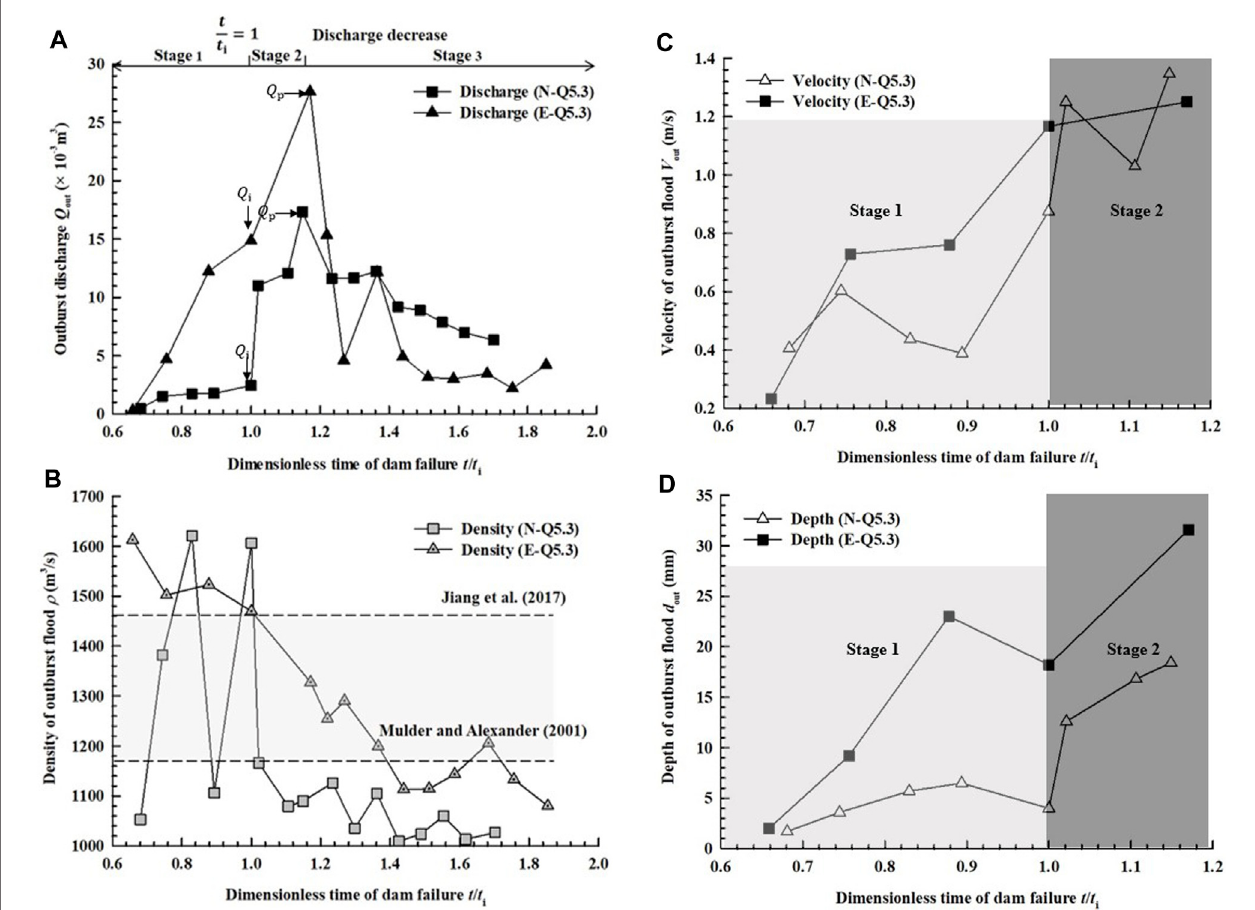
FIGURE 11 | The (A) discharge of the outburst fl oods and (B) density of the outburst fl ood in tests N-Q5.3 and E-Q5.3. The (C) velocity and (D) water depth of outburst fl oods in Stages 1 and 2.